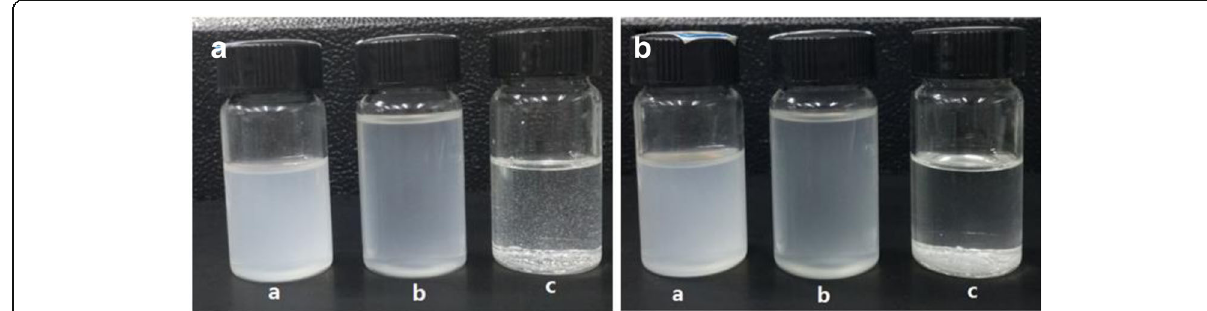
Fig. 3 Photographic images of ZrP nanoplatelets in mineral oils a right after dispersion and b after dispersion for 2 h. Sample a C16-ZrP, sample